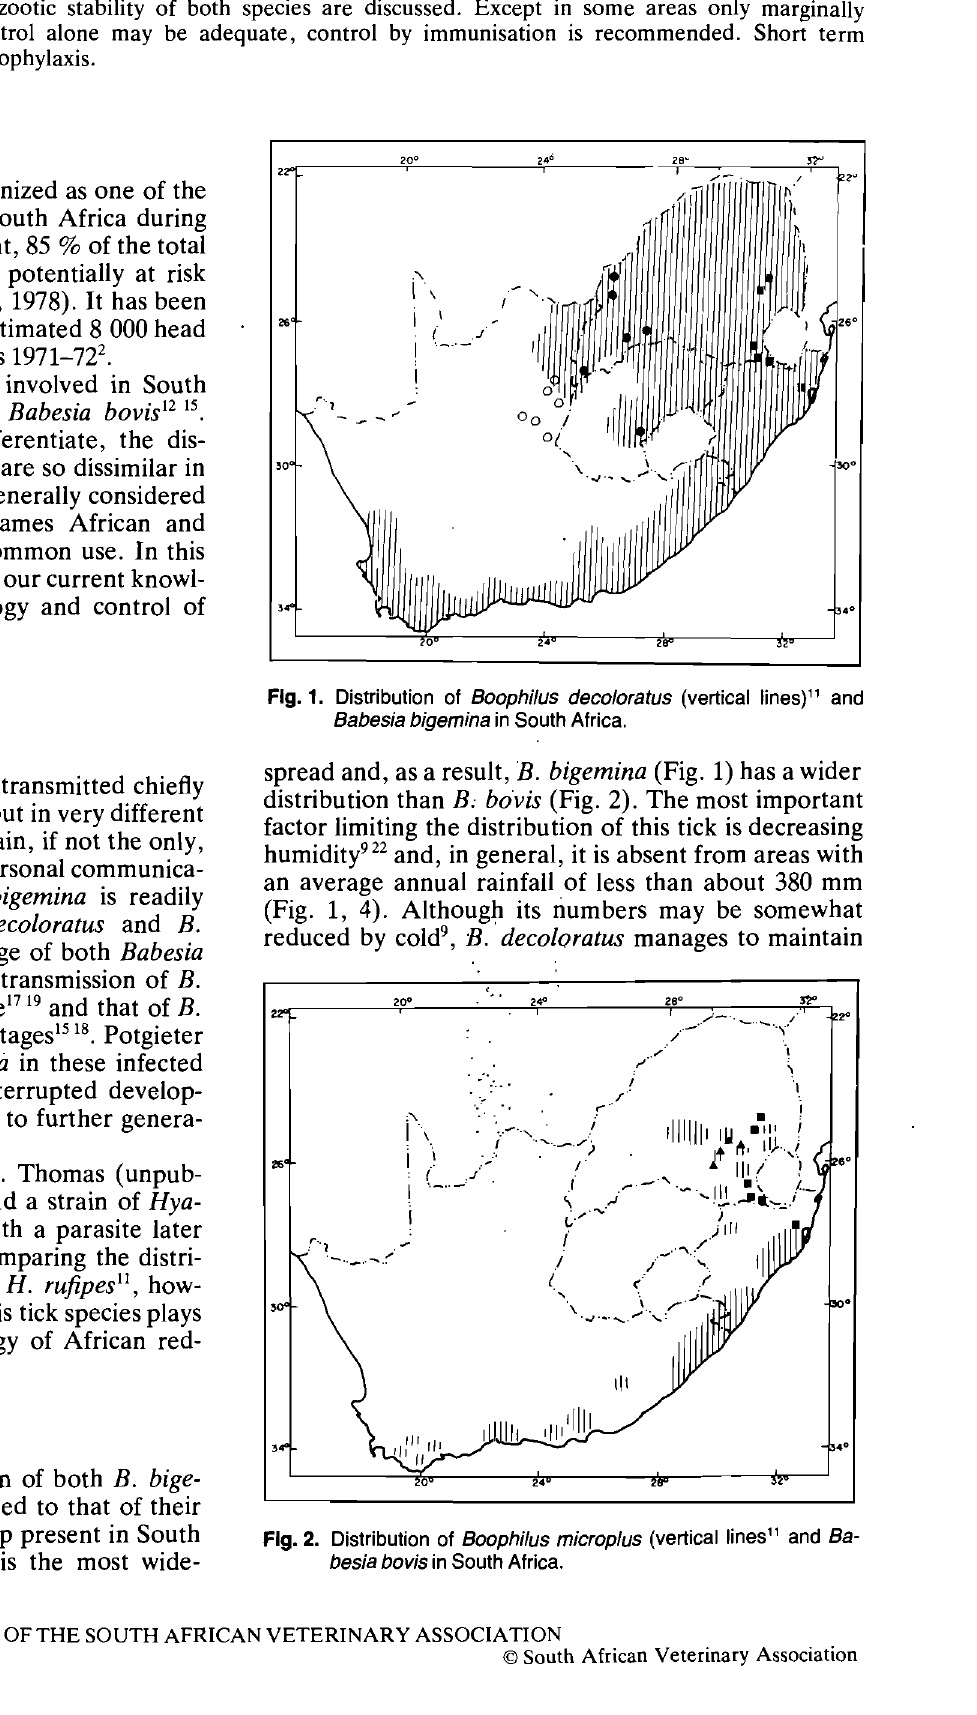
JOURNAL OF THE SOUTH AFRICAN VETERINARY ASSOCIATION